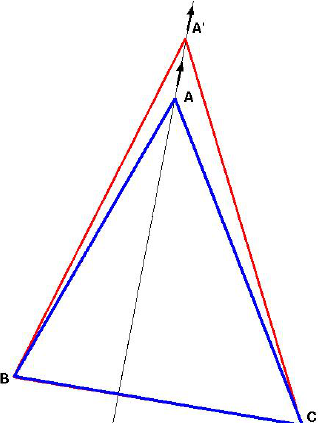
Figure 4. How does angle A change as it moves further from BC indefinitely, along a line that passes between B and C, e.g. to A (cid:48) and